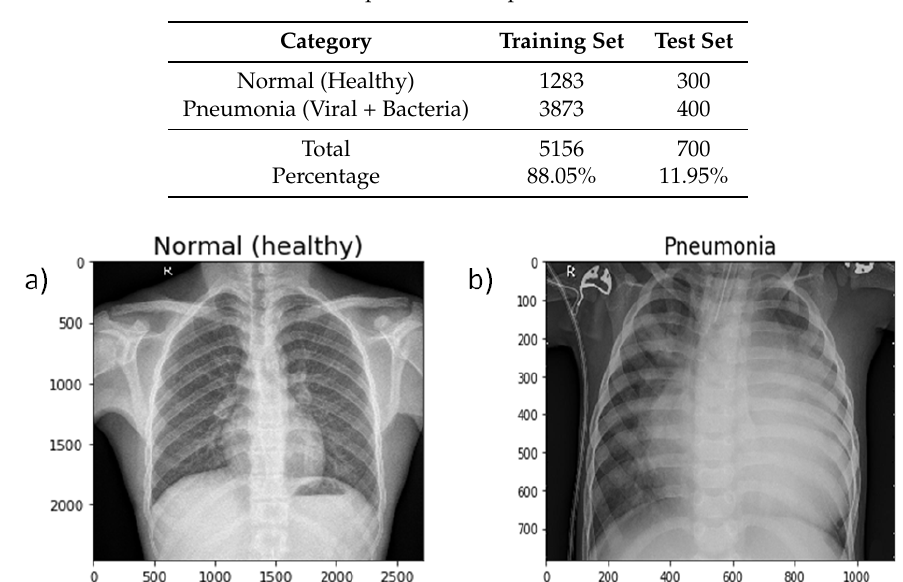
Figure 2. Chest Xray of ( a ) a healthy person and ( b ) a person suffering from pneumonia.